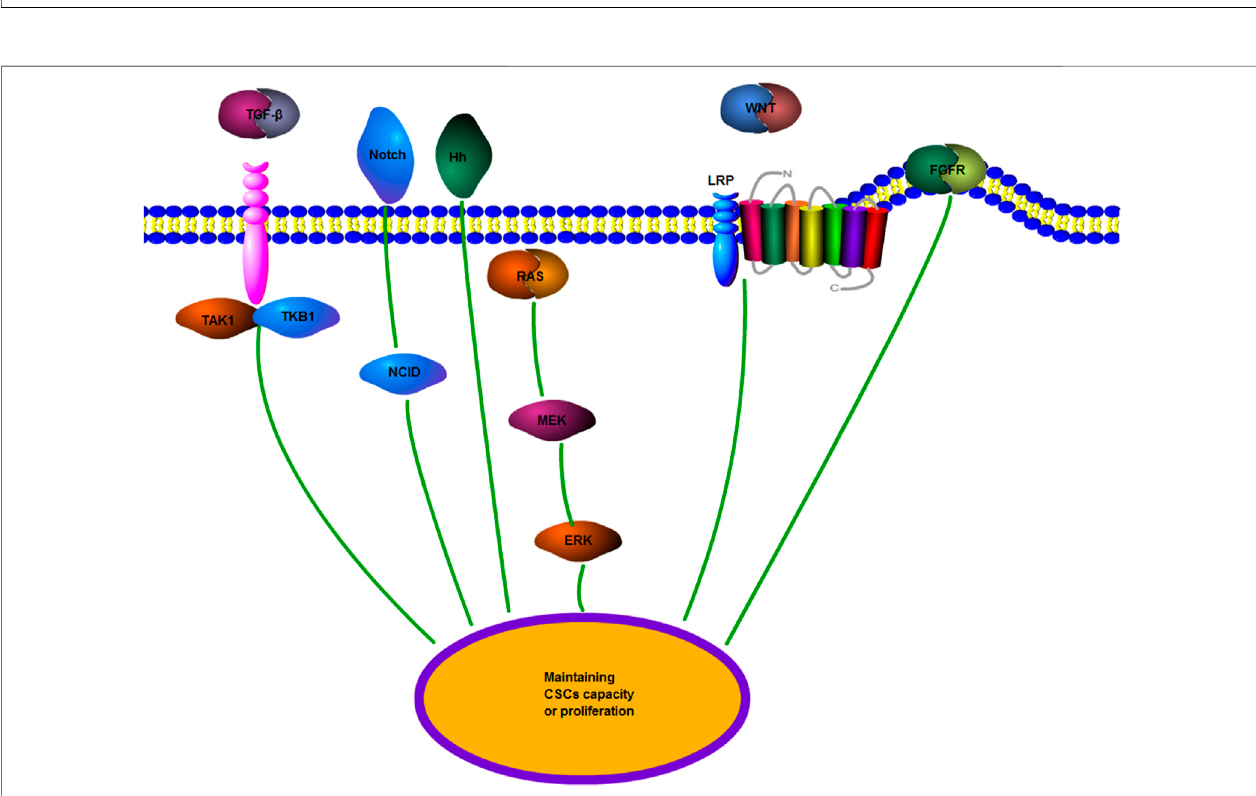
FIGURE 6 | CSCs regulate drug resistance-related signaling pathways. TGF- β , transforming growth factor- β ; Wnt/ β -catenin; Hh, Hedgehog: Notch; FGFR, fi broblastgrowthfactorreceptor;andMEK,mitogen-activatedproteinkinase.MultiplesignalingpathwayspromotethetransformationoftumorcellstoCSCstomaintain the features of CSCs or promote the growth and proliferation of